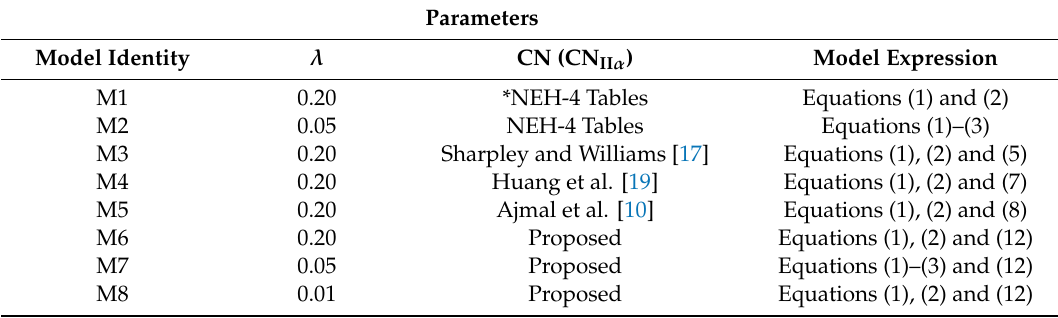
Table 1. Models and their